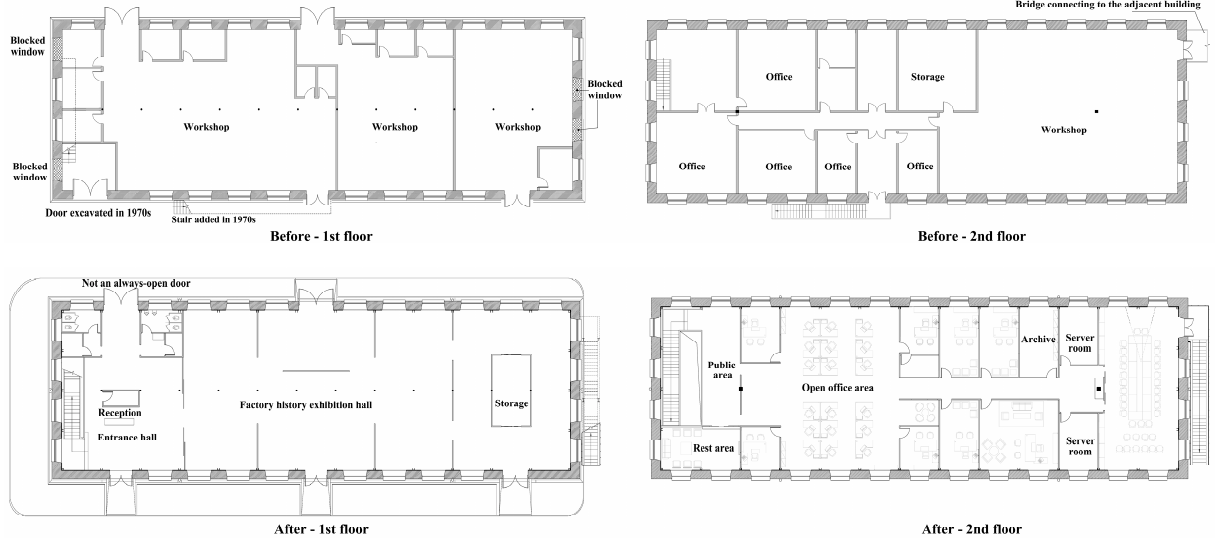
Figure 17. The comparison of plans before and after repurposing. Pictures by X.X.